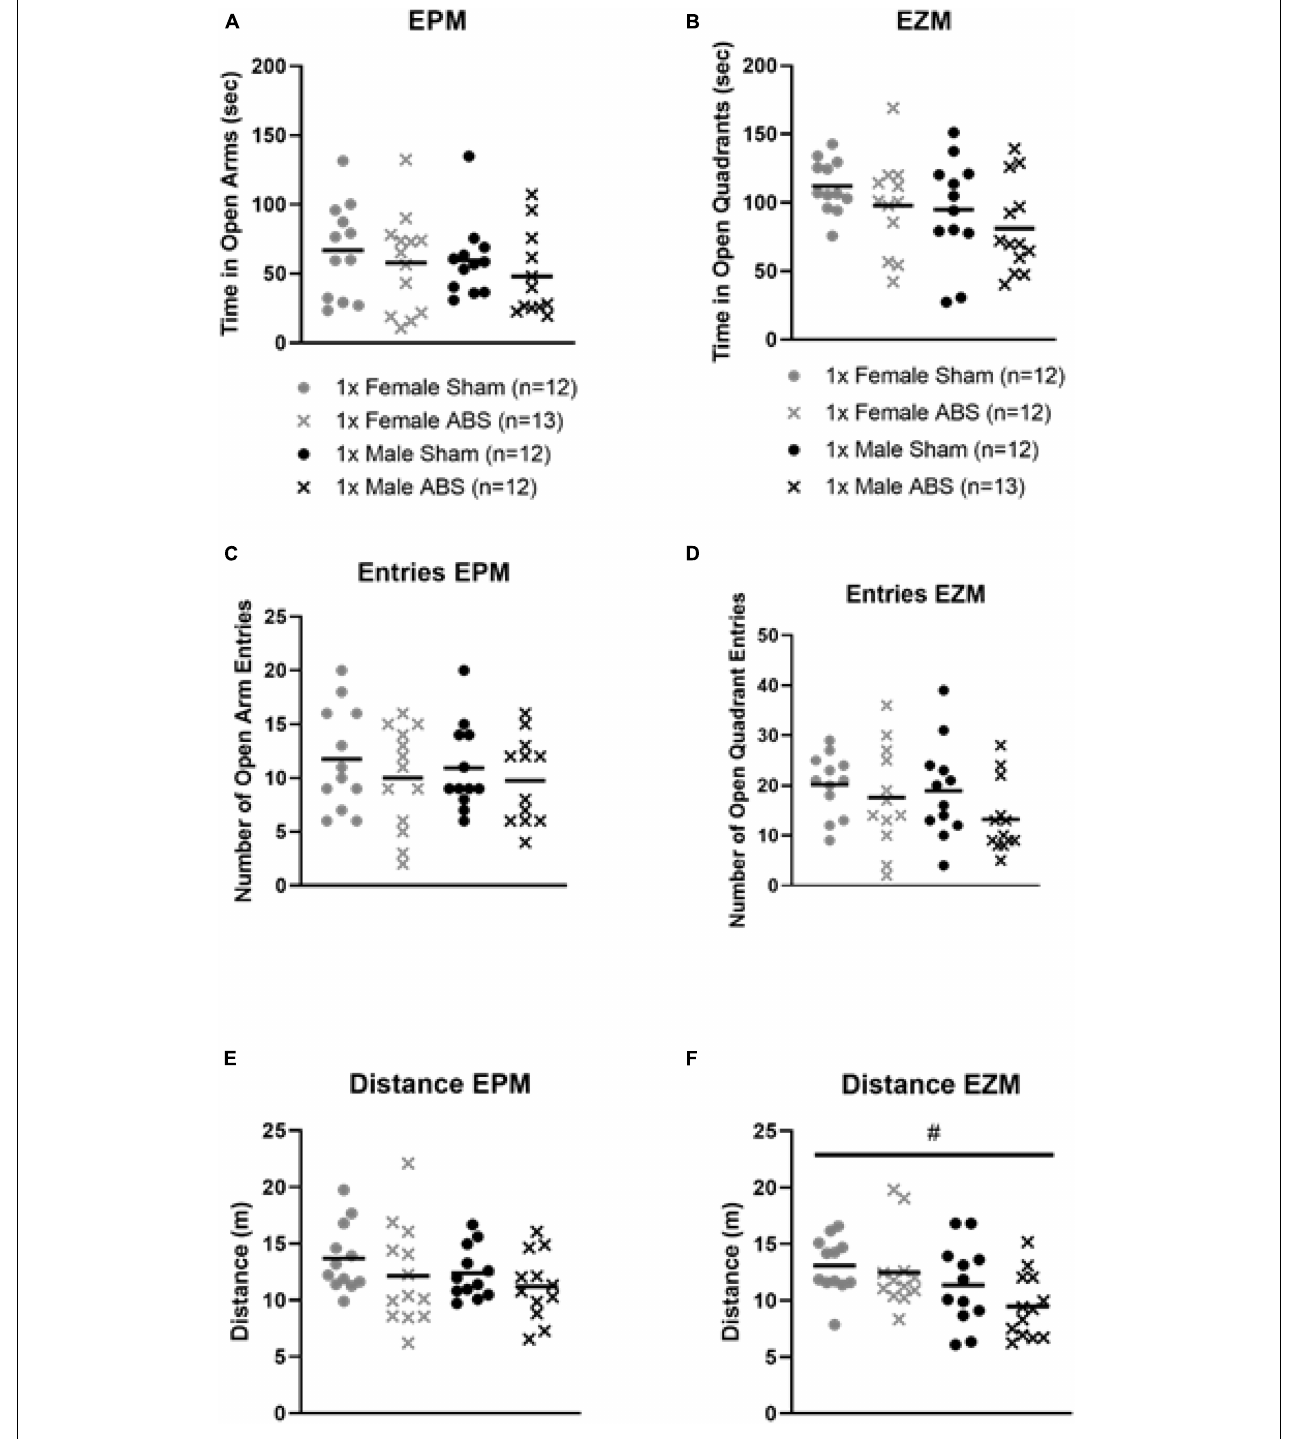
FIGURE 4 | No changes in anxiety-like behaviors on the EPM of EZM after injury, but a sex difference was displayed for EZM distance travelled. The results from the (A) EPM and (B) EZM testing show no difference in terms of time spent in the open areas for injury or sex. The number of open region entries also did not significantly differ for (C) EPM or (D) EZM. ABS group and sham animals for each behavioral task. (E) The total distance travelled was not statistically different between injured (ABS) or sham mice for EPM. (F) Results from the EZM testing indicated there was a main effect of sex where females travelled significantly farther than male mice ( p = 0.0112). Bars indicate means. # indicates main effect of sex p ≤ 0.05.